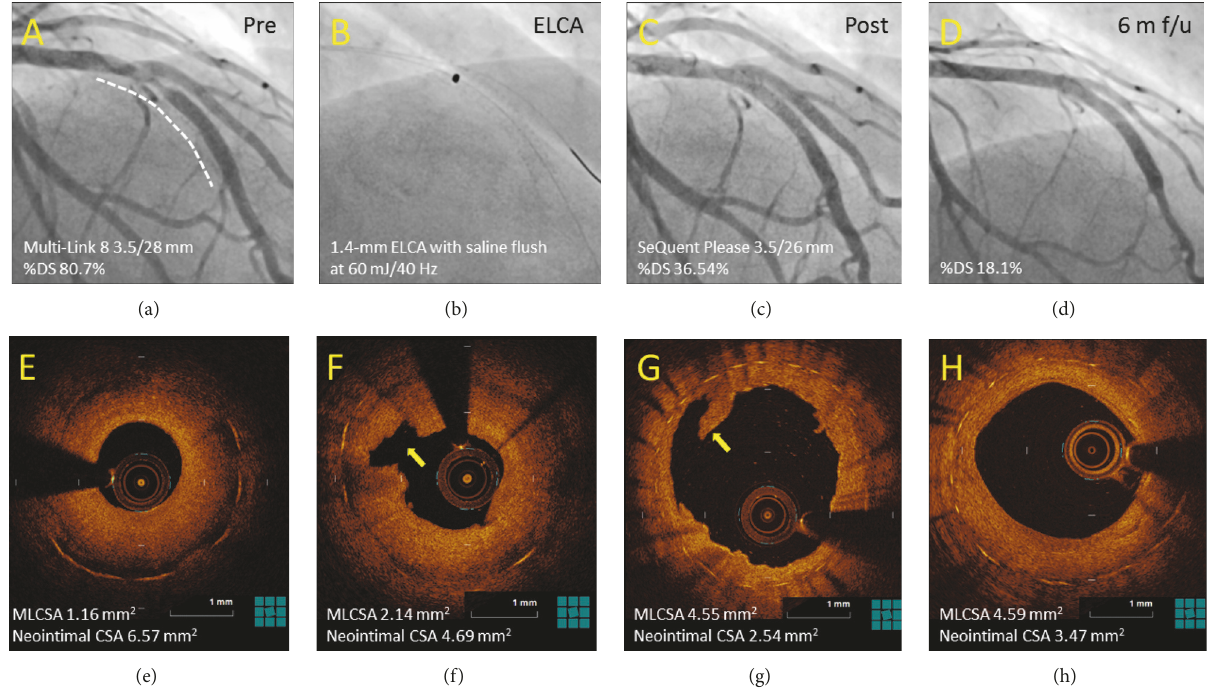
Figure 4: Representative angiographic and FD-OCT images: dissection and healing. The angiographic and FD-OCT images are shown before, after the PCI procedure, and at 6 months of follow-up in the ELCA group (a–h). (a) Baseline angiogram showing BMS ISR in the LAD (white dotted line). (b) 1.4-mm ELCA with saline flush at 60 mJ/40 Hz. (c) Final angiogram after DCB dilatation (SeQuent Please 3.5/26 mm inflated at 8 atm for 45 seconds). (d) Six-month follow-up angiogram. (e) Pre-PCI FD-OCT image. (f) Cavities after ELCA (yellow arrow). (g) Flap dissections after PCI (yellow arrow). (h) Completely healed with restoration of smooth luminal contour at 6 months of follow-up. FD-OCT, frequency-domain optical coherence tomography; PCI, percutaneous coronary intervention; ELCA, excimer laser coronary atherectomy; BMS, bare-metal stent;ISR, in-stentrestenosis; LAD, left anterior descending artery; DCB, drug-coated balloon; PCI, percutaneous coronary